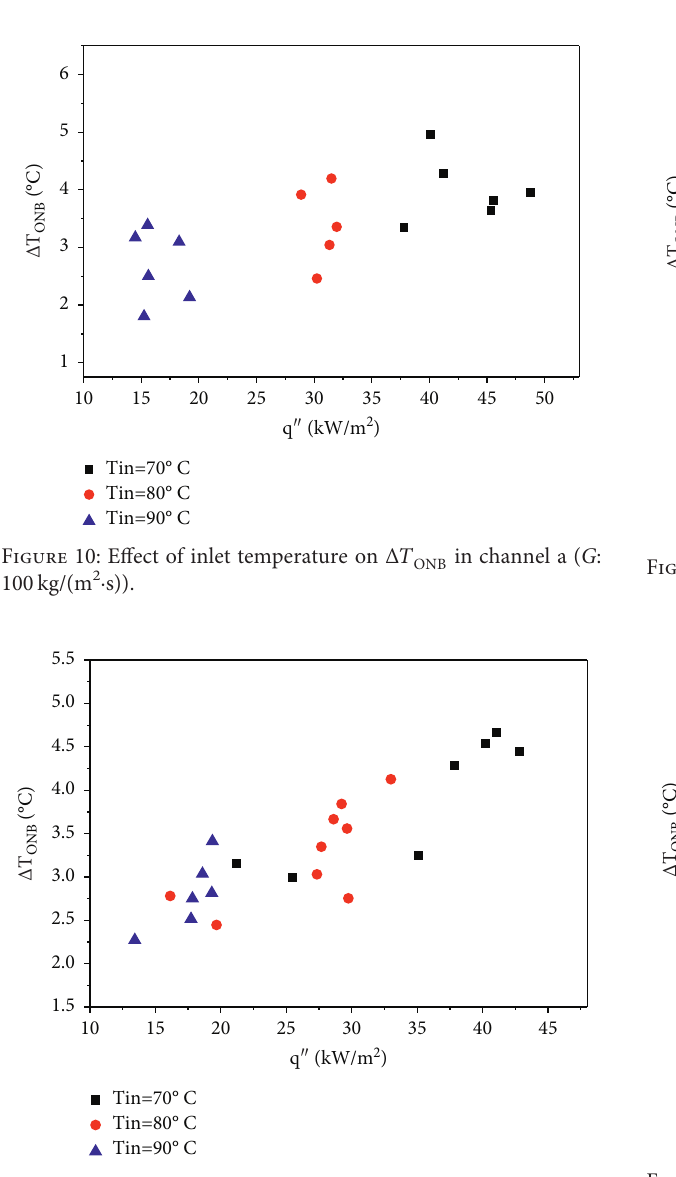
in channel b ( G : ONB